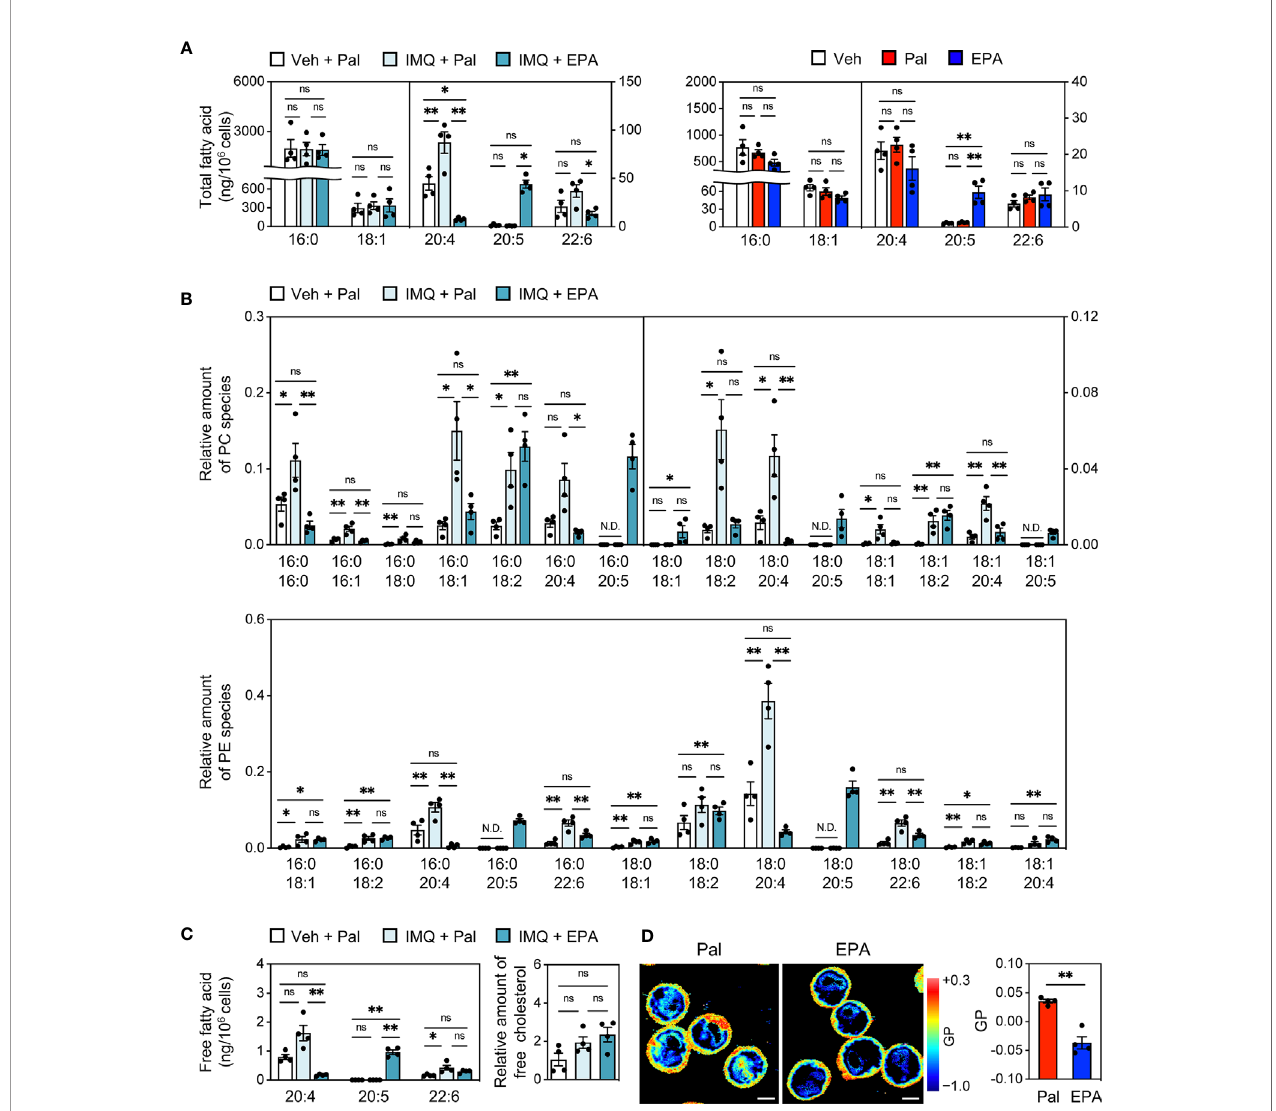
FIGURE 7 | EPA modulates lipid composition and dynamics of cellular membrane in B cells. (A) GC-MS analysis of total fatty acid in pan-B cells of spleen from Veh-treated mice fed Pal-supplemented diet, IMQ-treated mice fed Pal-supplemented diet, and IMQ-treated mice fed EPA-supplemented diet (left) and naïve B cells isolated from B6 +/+ spleen stimulated with CD40L (1 m g/ml) and IL4 (3 ng/ml) in the presence of ethanol (Veh), Pal (50 m M) or EPA (50 m M) overnight (right). (B, C) LC-MS/MS analysis of phosphatidylcholine (PC) species (B, top), phosphatidylethanolamine (PE) species ( B , bottom), free fatty acid ( C , left) and free cholesterol ( C , right) in pan-B cells of spleen from Veh-treated mice fed Pal-supplemented diet, IMQ-treated mice fed Pal-supplemented diet, and IMQ-treated mice fed EPA-supplemented diet. (D) Laurdan general polarization (GP) images of Ba/F3 cells (left) and quanti fi ed GP value of whole cells (right). Ba/F3 cells were treated with Pal (100 m M) 8 h then replaced by medium containing of Pal (100 m M) or EPA (100 m M) and incubated overnight. The GP value of each pixel was used to generate pseudocolored GP image. Higher GP value indicates more ordered and less dynamic membrane. Original magni fi cation: × 600, Scale bars represent 5 m m. n = 4 per group. Data shown are mean value ± SEM. Statistical analysis was performed with Dunn ’ s test ( A (left): 20:5, B (top): 16:0/20:4, 18:0/18:2, 18:1/18:1, C : 20:4), unpaired Student ’ s t test (D) or Tukey ’ s test (if not otherwise stated). *p < 0.05; **p < 0.01; ns, not signi fi cant; N.D., not